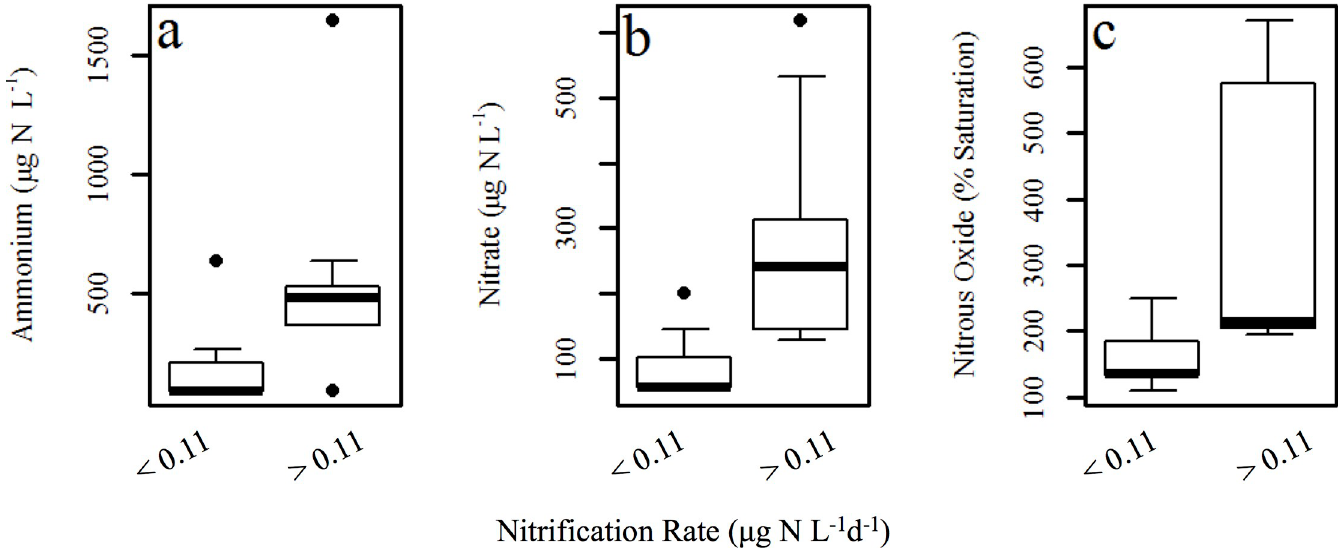
Fig 4. Concentrations of NH 4+ and NO 3– , and N 2 O percent saturation partitioned according to nitrification rates that are above or below 0.11 μ g N L -1 d -1 . There are significant differences between the two rate groups for all analyses (NH 4+ , NO 3– , and N 2 O; Wilcox-Mann-Whitney test, P < 0.05). The boxplot and whiskers encompass 95% of the data observed, data points outside of the box and whiskers are outliers. The box itself represents the first and third quartiles, and the center line is the median [65].